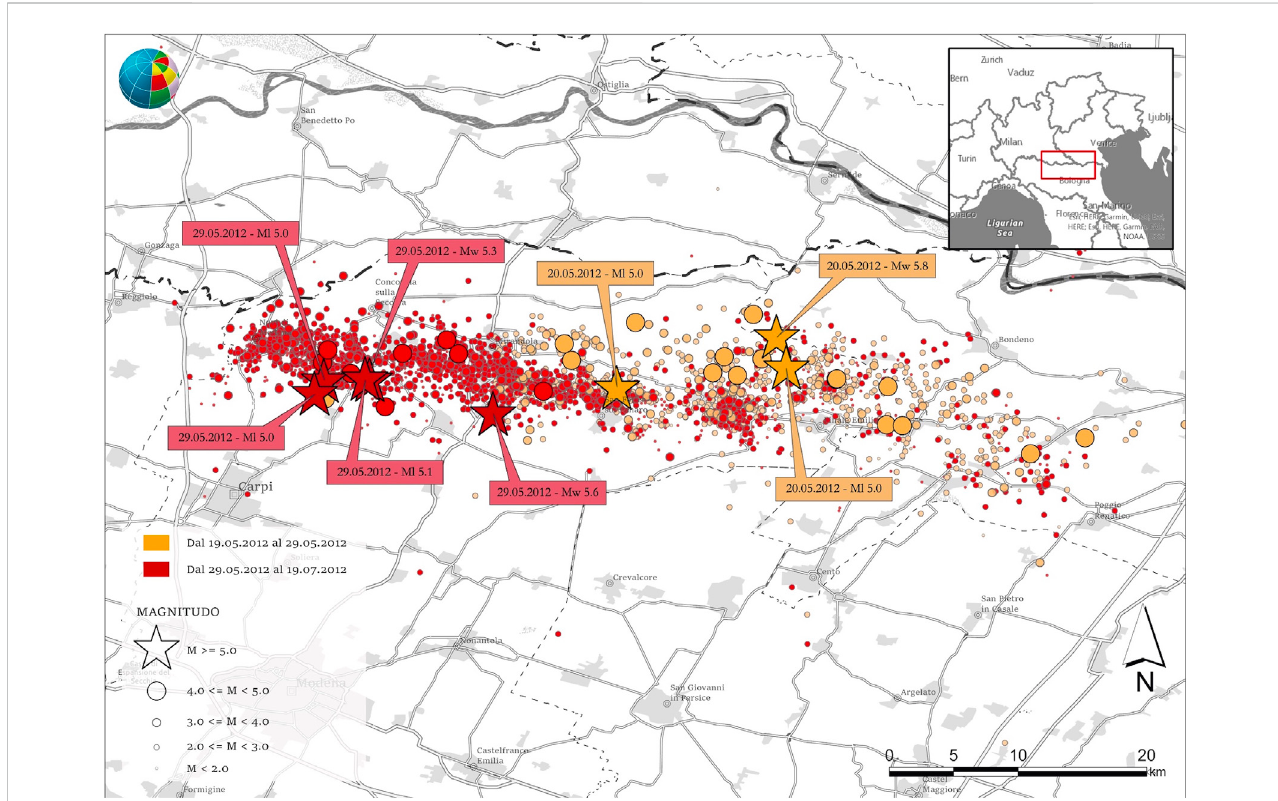
FIGURE 1 Themainshocksofthe2012EmiliaRomagnaseismicsequence.Thesizeofthepointsre fl ectsthemagnitude,asshowninthelegend.Forthesixgreatest events (stars), the labels report the date (day.month.year) and the magnitude. The image is taken from a blog article published on the INGVterremoti blog on the 10th anniversary of the sequence (modi fi ed after https://ingvterremoti.com/2022/05/21/terremoti-in-pianura-padana-10-anni-dopo-i-numeri-della-